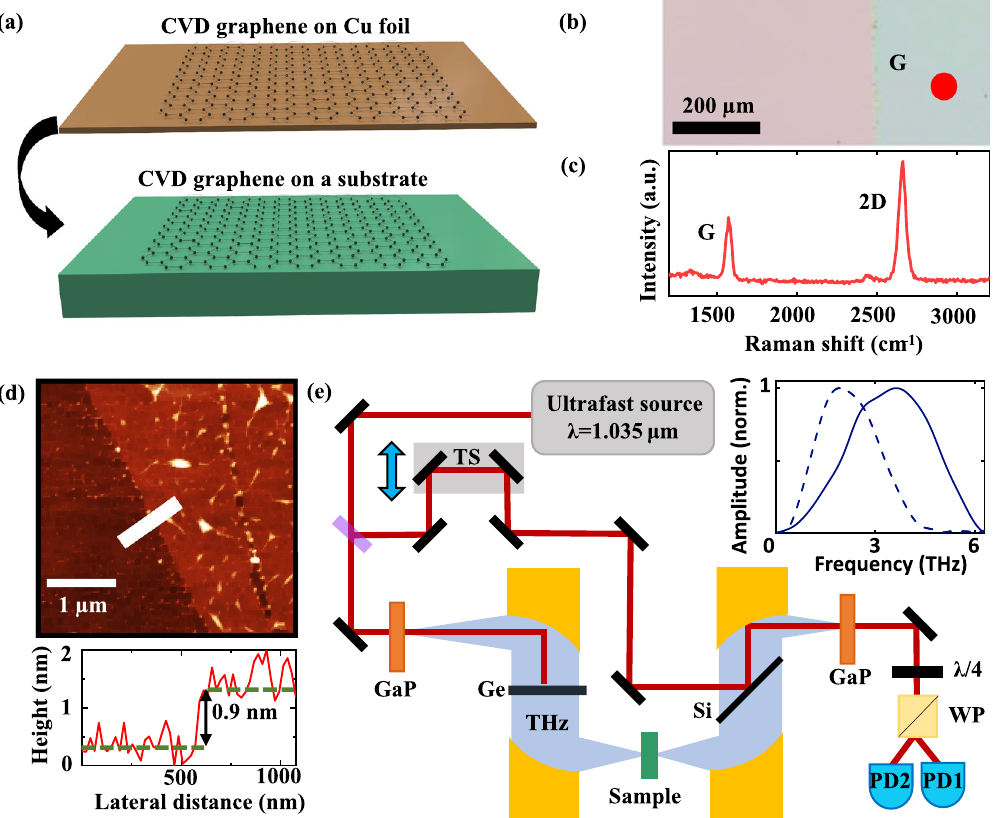
Figure 1. Sample fabrication and experimental set-up. ( a ) Schematic of sample fabrication: CVD graphene on Cu foil is transferred onto a desired substrate. ( b ) 5X optical microscope image of graphene (right section) on SiO 2 (left section). ( c ) Raman spectrum of a transferred graphene film featuring distinctive G and 2D peaks. ( d ) Atomic force micrograph of graphene transferred on SiO 2 together with a height profile across the graphene edge, indicated by the white line. ( e ) Schematic of the time-domain terahertz spectrometer with its optical components: beam splitter (BS), translation stage (TS), gallium phosphide crystals (GaP), germanium and silicon wafer (Ge and Si), quarter wave plate (QWP), Wollaston prism (WP), and balanced photodetectors